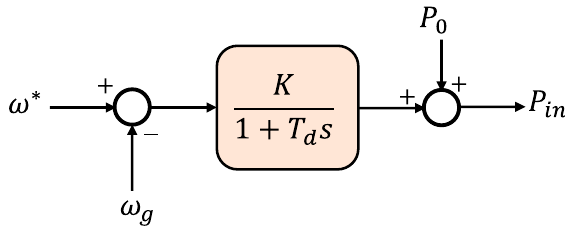
Figure 10. Ise Lab’s topology: the governor model [18].